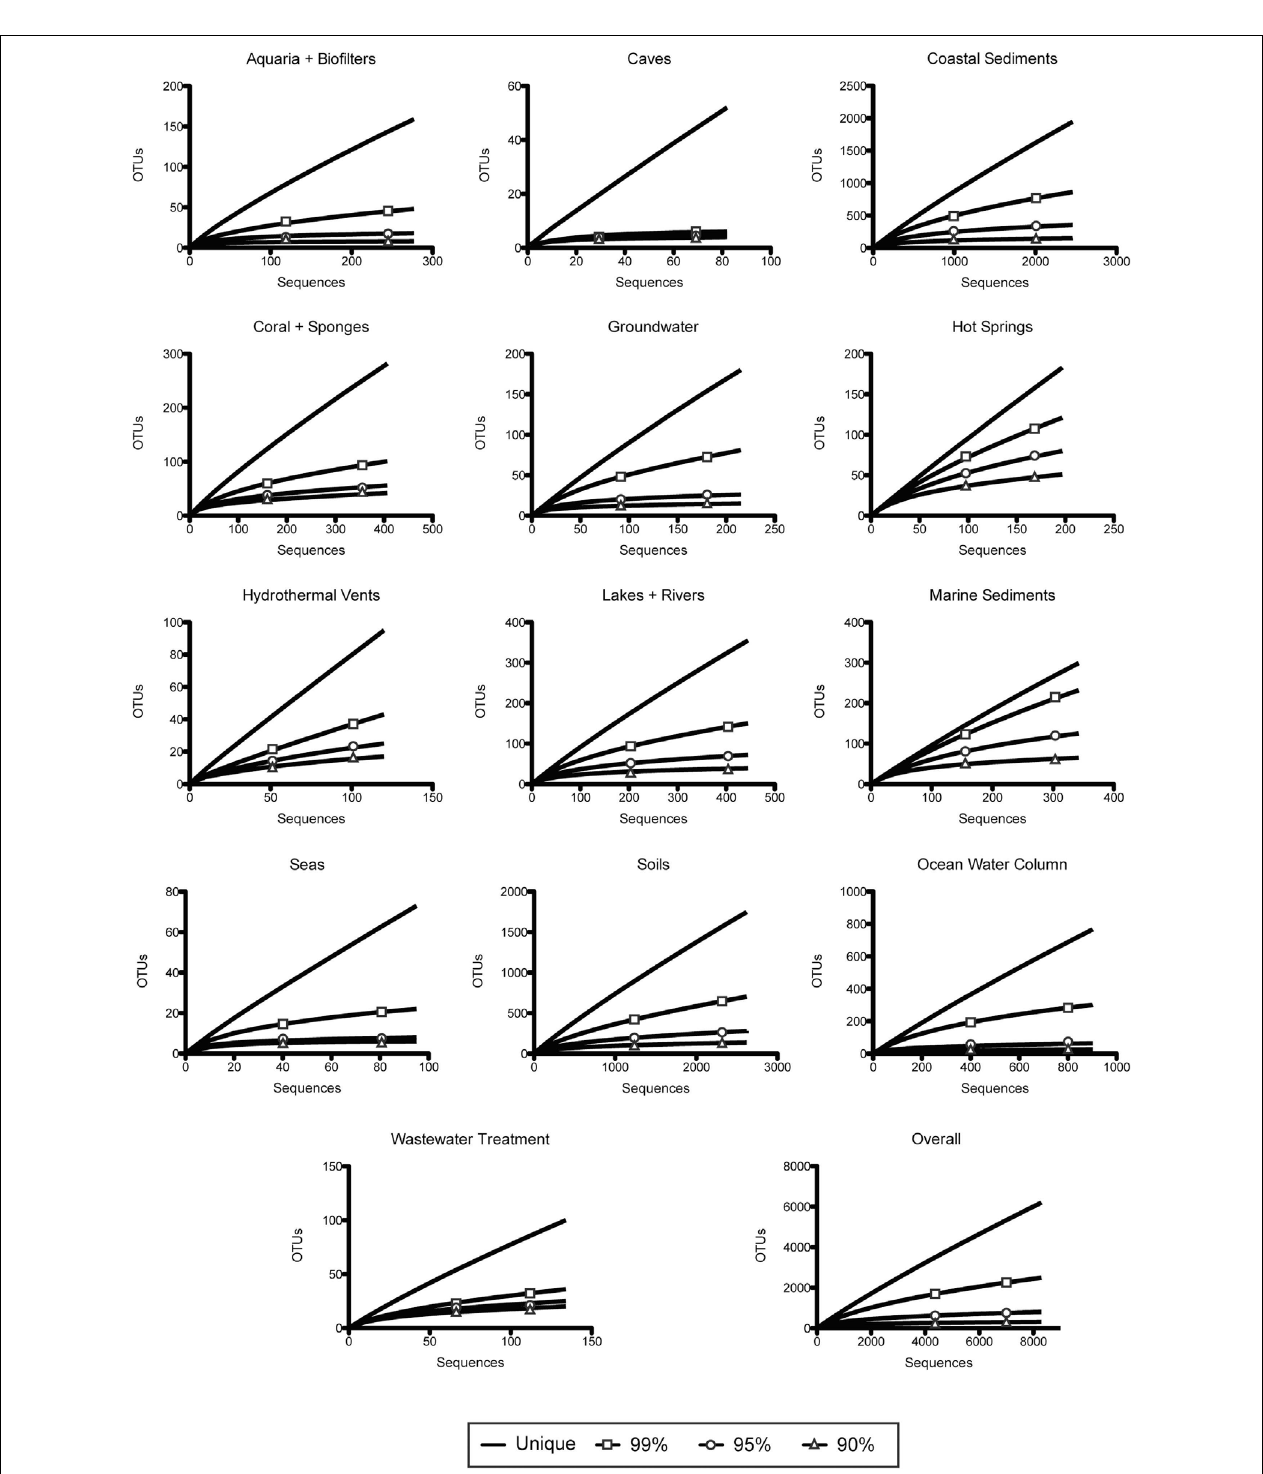
FIGUREA2 | Rarefaction analysis of amoA sequence diversity, by habitat type. Curves represent rarefaction analysis of unique sequences and OTUs defined by 99, 95, and 90% identity.